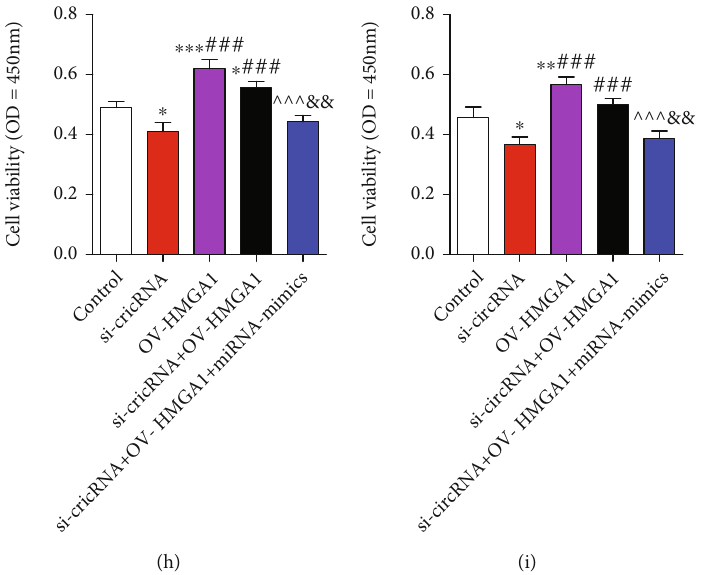
Figure 4: HMGA1 is a direct target of hsa-miR-296-5p, and overexpression of HMGA1 can promote proliferation of SiHa and HeLa cells. Like hsa_circ_0000511, HMGA1 was highly expressed in SiHa and HeLa cells than in H8 and C-33A cells (a) ( mean ± SD ; the data were analyzed by one-way analysis of variance; vs. H8, ∗∗ p < 0 : 01 ; vs. C-33A, ## p < 0 : 01 ). The results of Western blot (b) showed that the protein expressions of HMGA1 were changed when hsa-miR-296-5p was inhibited or not in SiHa (c) and HeLa (d) cells, and a dual- luciferase reporter assay (e) indicated that HMGA1 is a direct target of hsa-miR-296-5p ((c, d) mean ± SD , the data were analyzed by one- way analysis of variance; vs. mimics-NC, ∗∗ p < 0 : 01 and ∗∗∗ p < 0 : 001 ; vs. si-circ+miRNA inhibitor, ### p < 0 : 001 ; (f, g), vs. HMGA1 3 ′ -UTR (wt)+miRNA NC, ∗∗ p < 0 : 01 ). Moreover, CCK8 detection shown that overexpression of HMGA1 could promote proliferation of SiHa (h) and HeLa (i) cells. Mean ± SD ; the data were analyzed by one-way analysis of variance; vs. the control, ∗ p < 0 : 05 , ∗∗ p < 0 : 01 , and ∗∗∗ p < 0 : 001 ; vs. si-circRNA, ### p < 0 : 001 ; vs. OV-HMGA1, ^^^ p < 0 : 001 ; vs. si-circRNA+OV-HMGA1+miRNA mimics, && p < 0 : 01